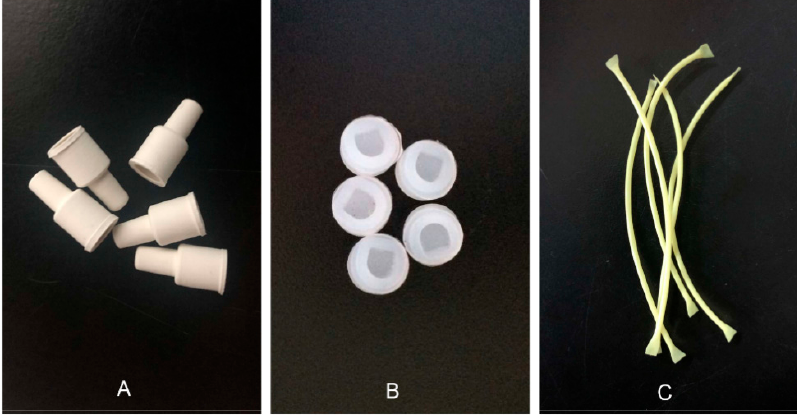
Figure 4. Three kinds of sustained-release dispensers were tested in the field trapping. ( A ) isoprene septa; ( B ) silicone septa; ( C ) PVC capillary tubing.